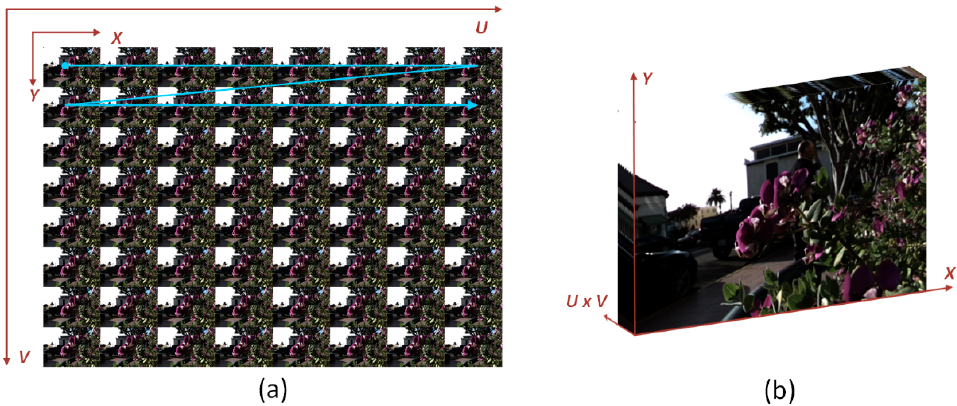
Figure 2. ( a ) The 4D LF representation as a 2D array of view images. ( b ) The 3D LF view image stack.